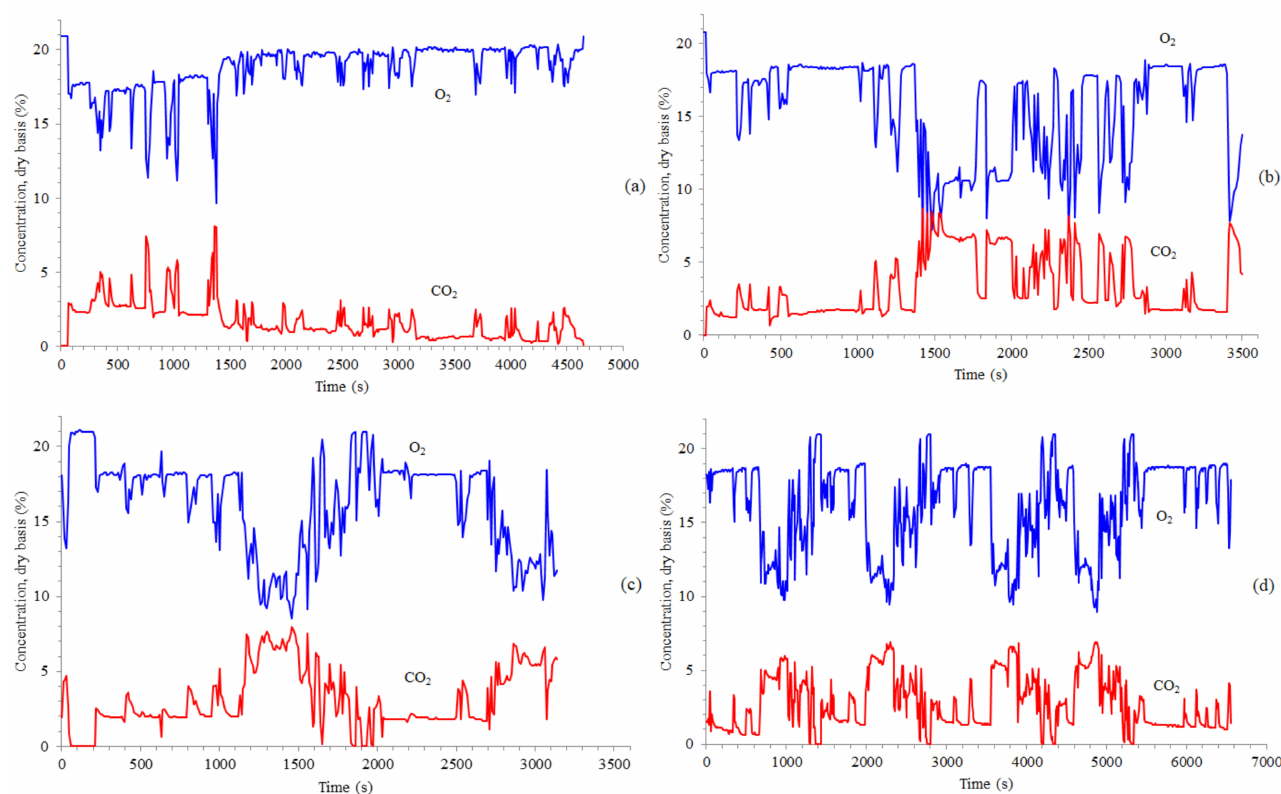
Figure 3. The O 2 and CO 2 concentrations as functions of time for all trucks: #1 ( a ), #2 ( b ), #3 ( c ), and #4 ( d